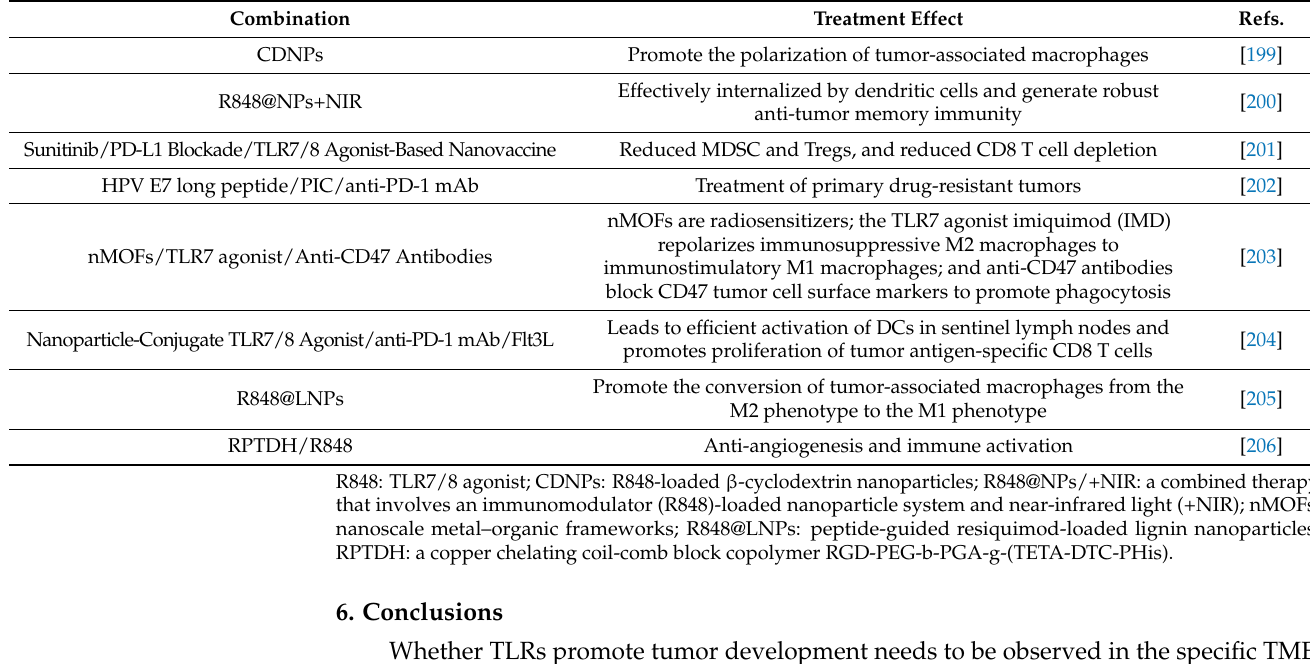
Table 4. Co-delivery of TLR agonists/antagonists with nanoparticle for cancer